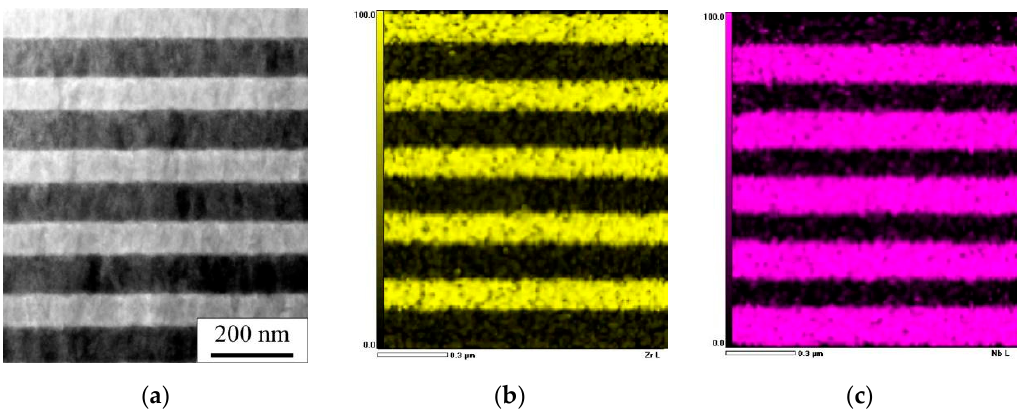
Figure 3. Cross-section STEM image ( a ) and EDS-mapping of Zr (yellow) ( b ) and Nb (pink) ( c ) layers of the as-deposited Zr/Nb NMC.